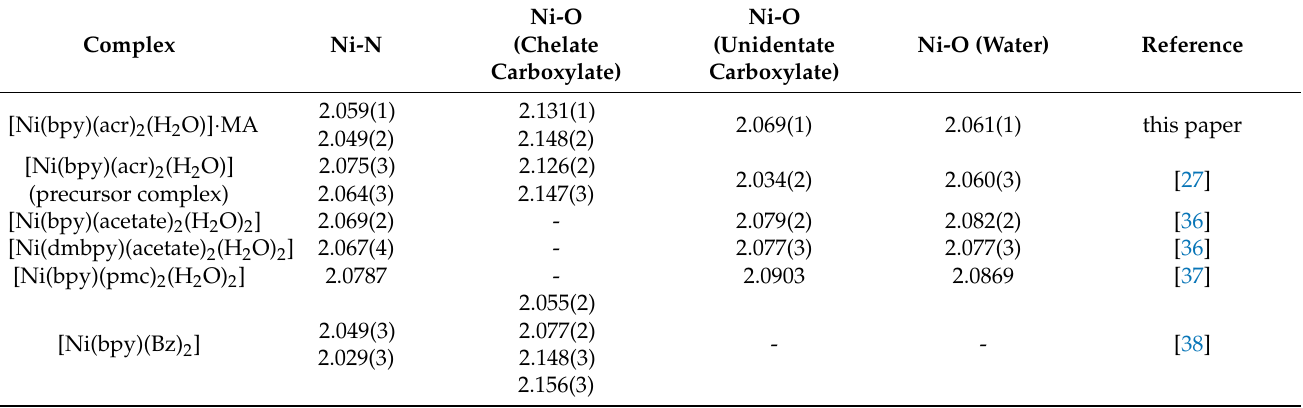
Table 1. Comparison of bond lengths (Å) for co-crystal complex and similar carboxylate species.